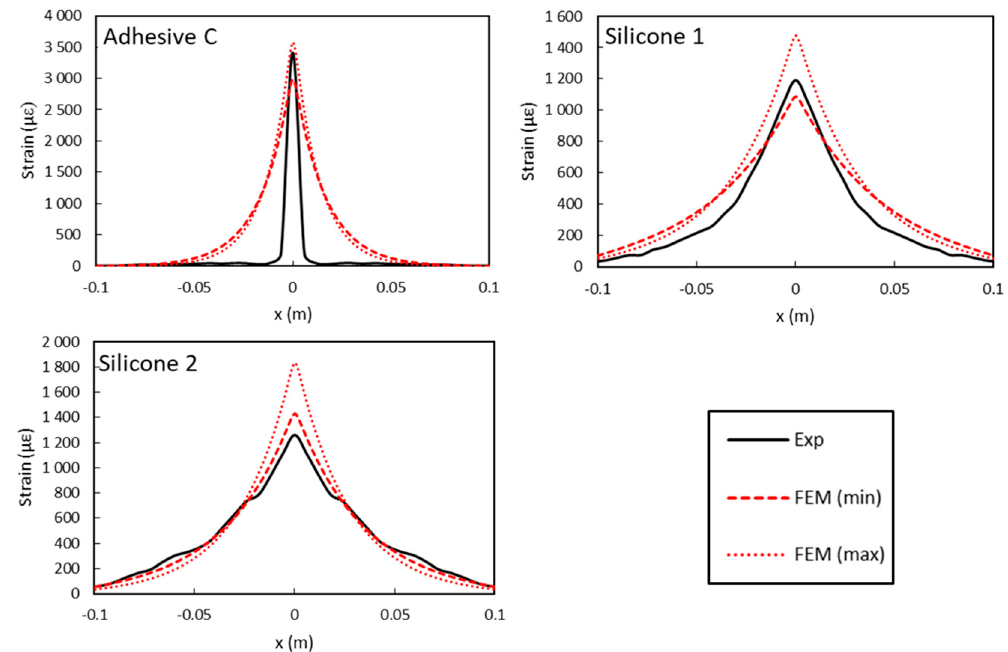
Figure 16. Comparison of numerical simulations (considering extreme values of the adhesive Young’s modulus—min and max) with the experimental (exp) strain profiles (gauge length: 6 mm) collected by DOFS for a displacement of 0.7 mm of the universal testing machine (UTM) actuator.